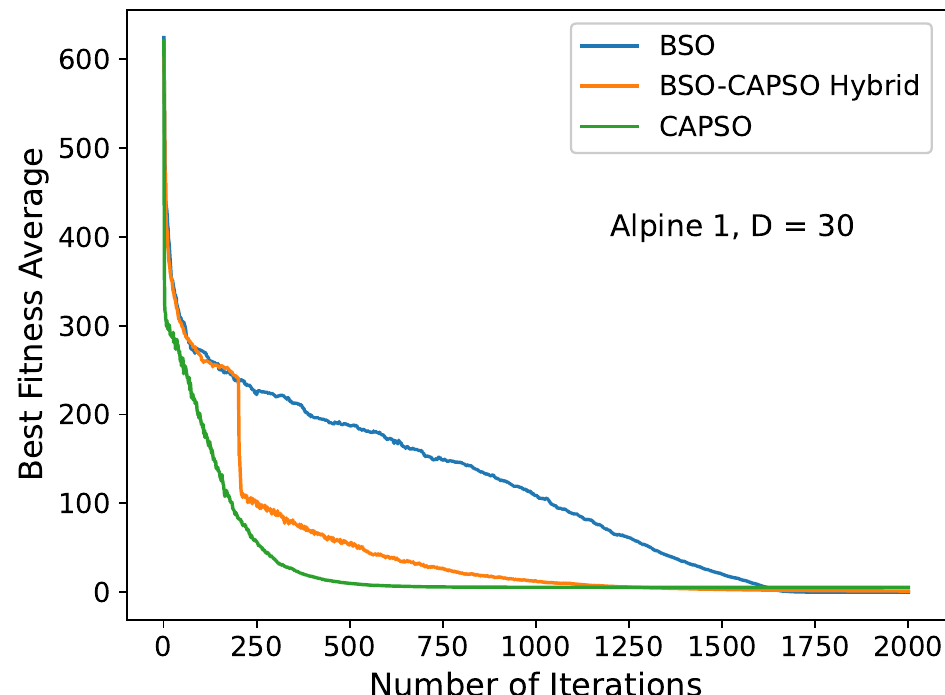
Figure 10. Convergence diagram of the stand-alone BSO, BSO–CAPSO hybrid and stand-alone CAPSO algorithms for the Alpine 1 ( f 7 ) function with D = 30. Convergence acceleration occurred after t switch =